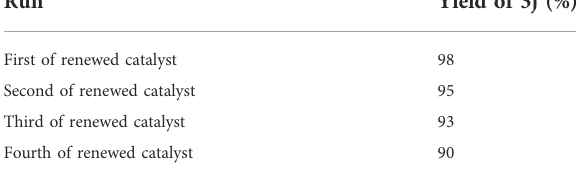
Run Yield of 3j